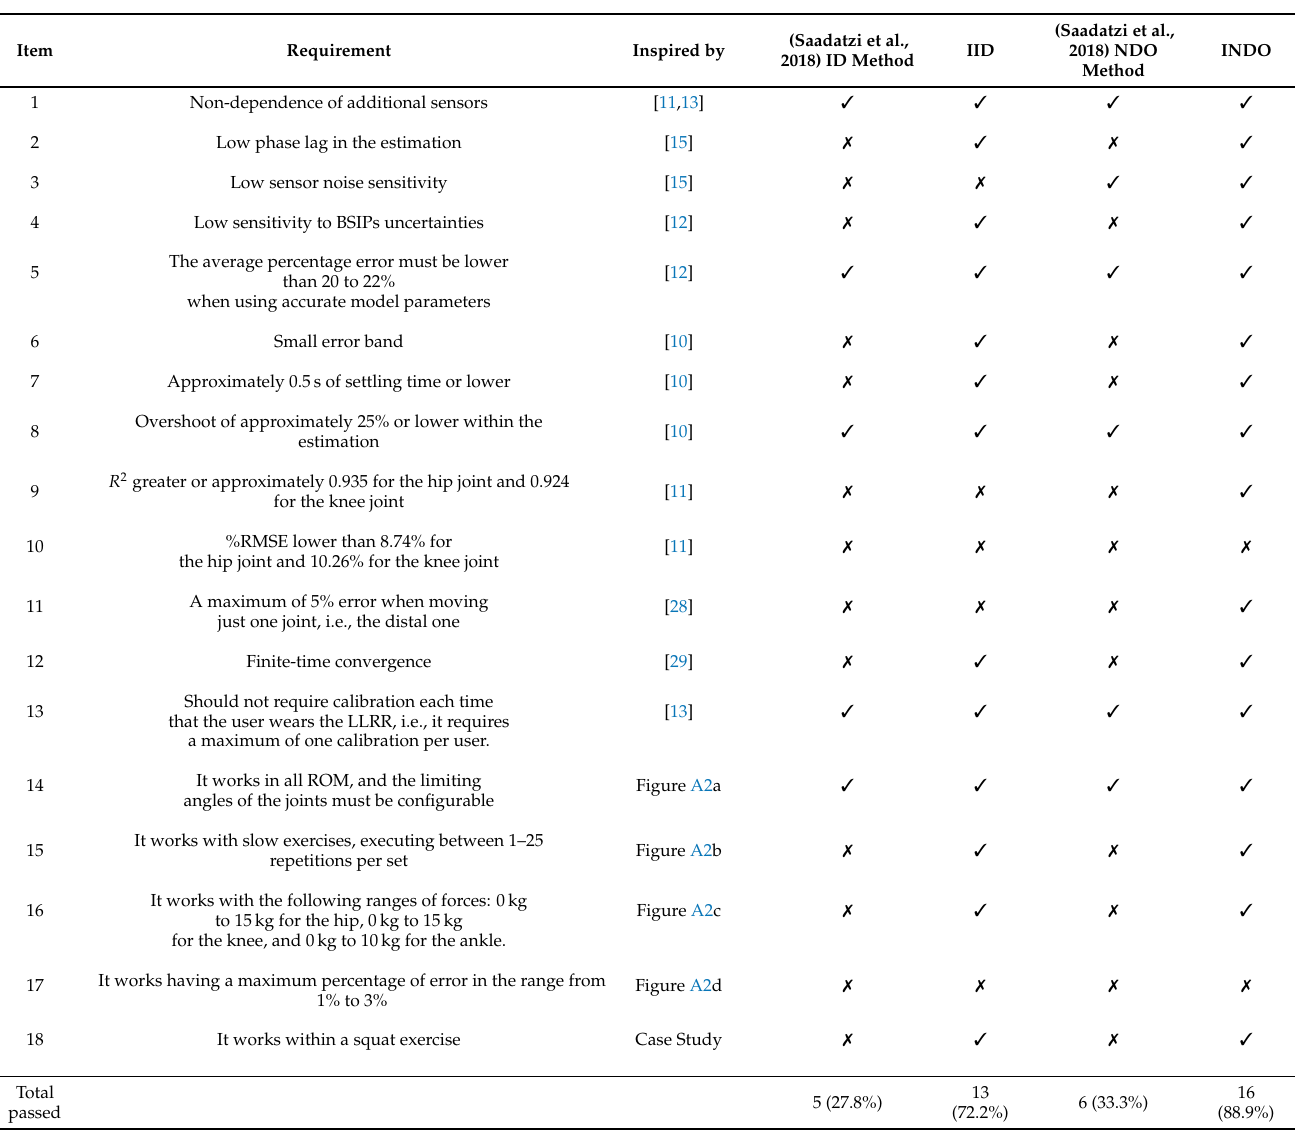
Table 5. Evaluation of the performance of the human–robot interaction torque estimation methods, during simulations with SNR = 40dB and 20% BSIPs uncertainties, according to the requirements defined in Section 2. The checkmark and cross-mark symbols represent whether the requirement is fulfilled or not,